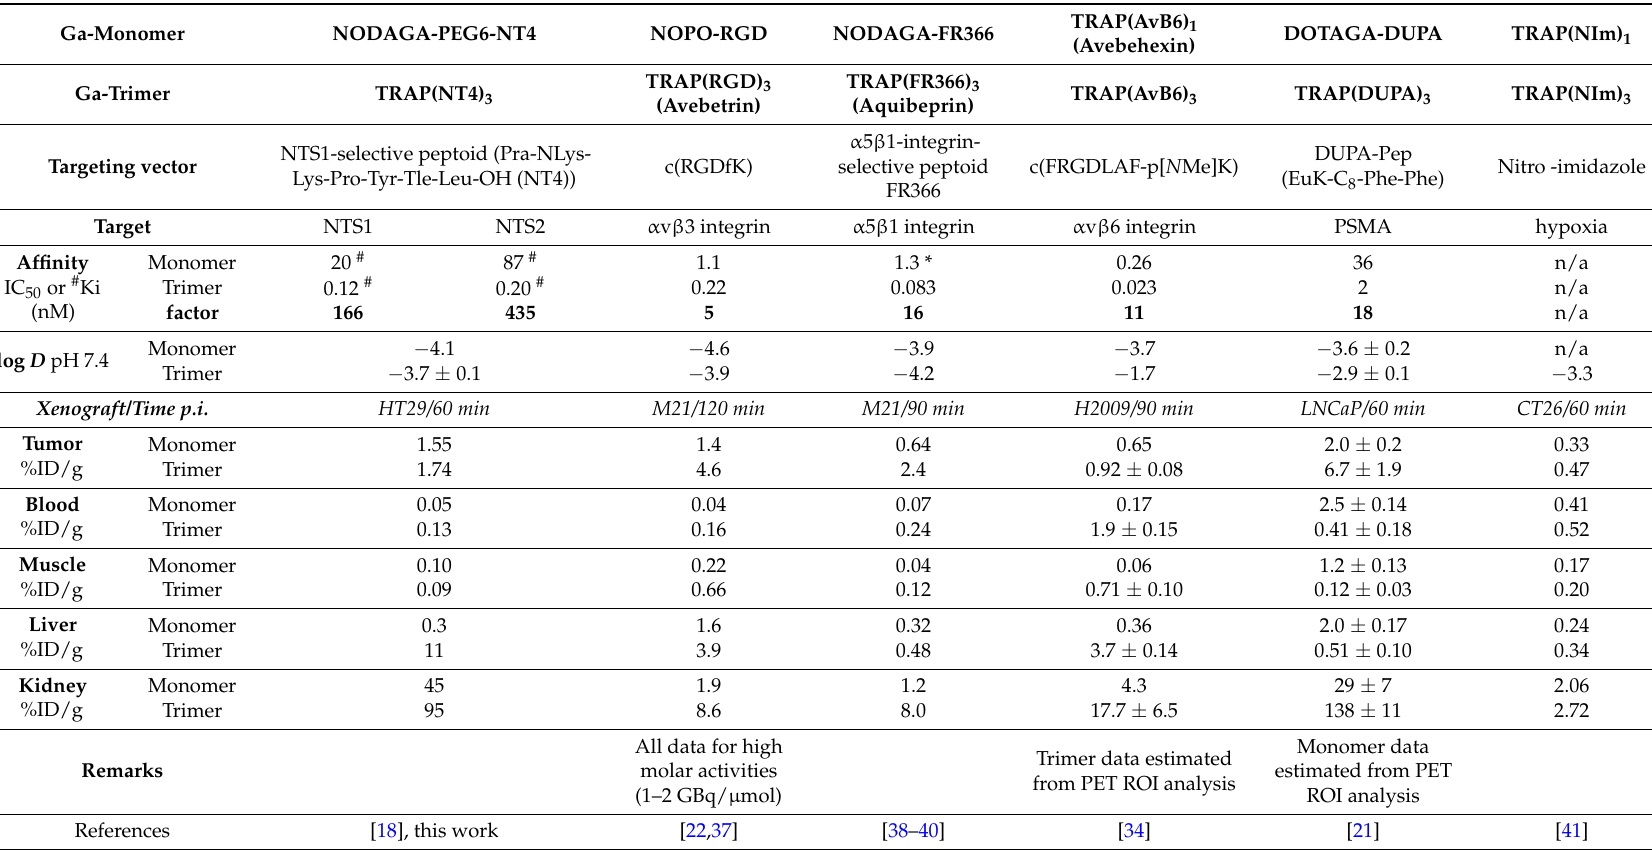
Table 3. Comparison of affinities, octanol/PBS distribution coefficients, and in vivo biodistribution data for selected TRAP-based trimers and monomeric chelator conjugates of the respective same targeting vectors, selected according to structural equivalence and availability of data for the same tumor models. Data were measured for the respective 68 Ga or nat Ga complexes, respectively, except those marked with an asterisk (*). Errors ( ± standard deviation) are given for data first reported herein, but are omitted for all other figures taken from the